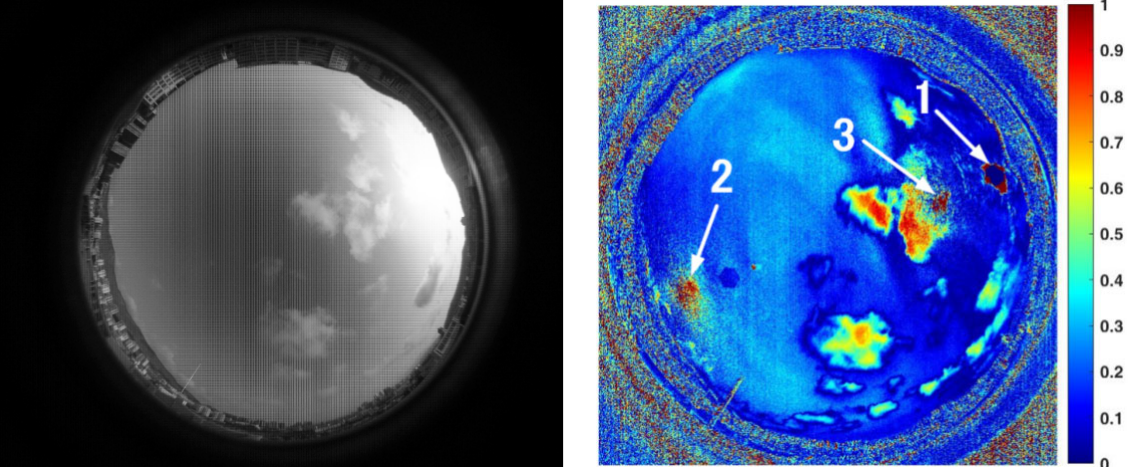
Figure 9. Polarization image under a partly cloudy condition and the corresponding NPDDI distribution result. The lack of polarization information brought by the Arago point and the Babinet point can be more clearly displayed.